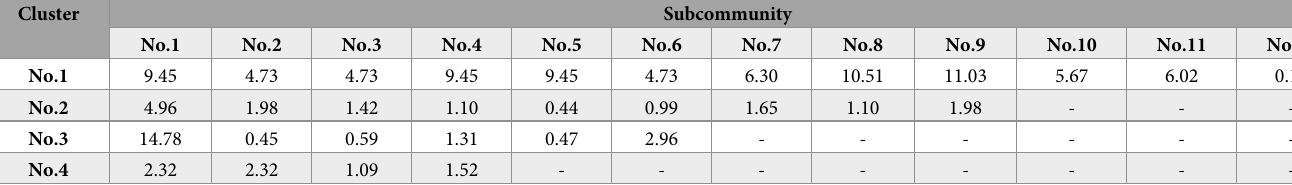
Table 2. The modularity of the subcommunity of the COVID-19 clusters in Zhejiang Province.